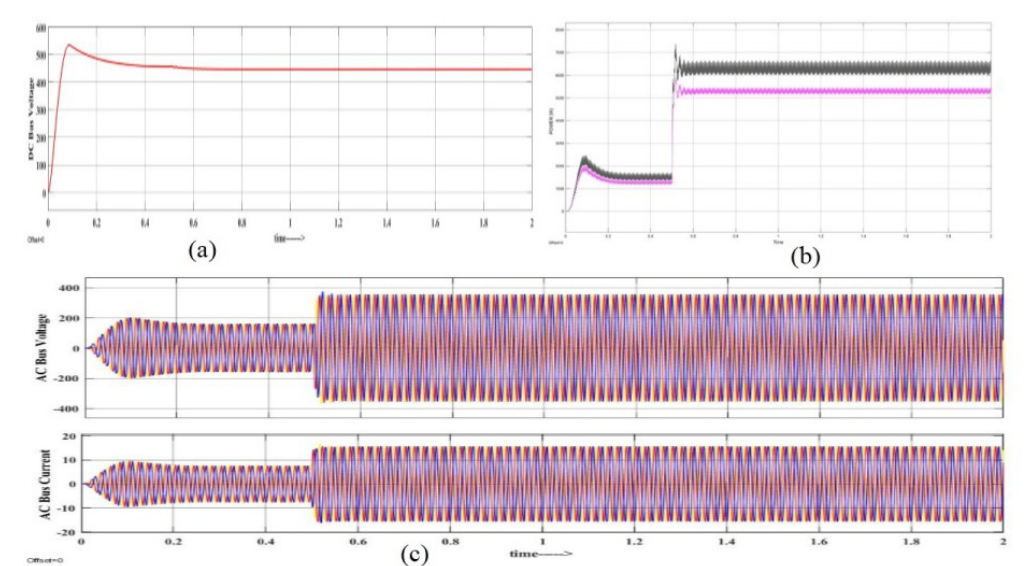
Fig. 9. System Parameters under grid connected mode with Icos Φ Controller: (a) DC bus voltage, (b) Grid Power, (c) AC bus voltage and